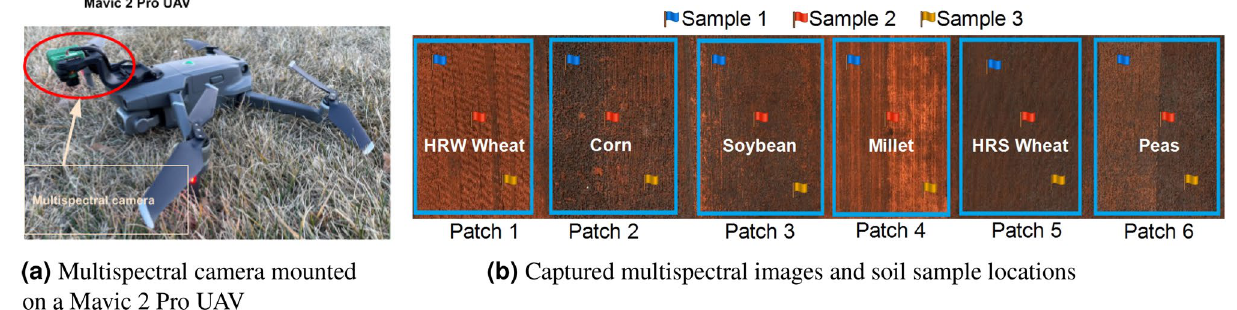
Figure 1. (a) Mavic 2 pro UAV with multispectral camera mounted. (b) The flags show the sample locations of the corresponding crops. The patches have crops including Peas, HRS Wheat, Millet, Soybean, Corn, and HRW Wheat,